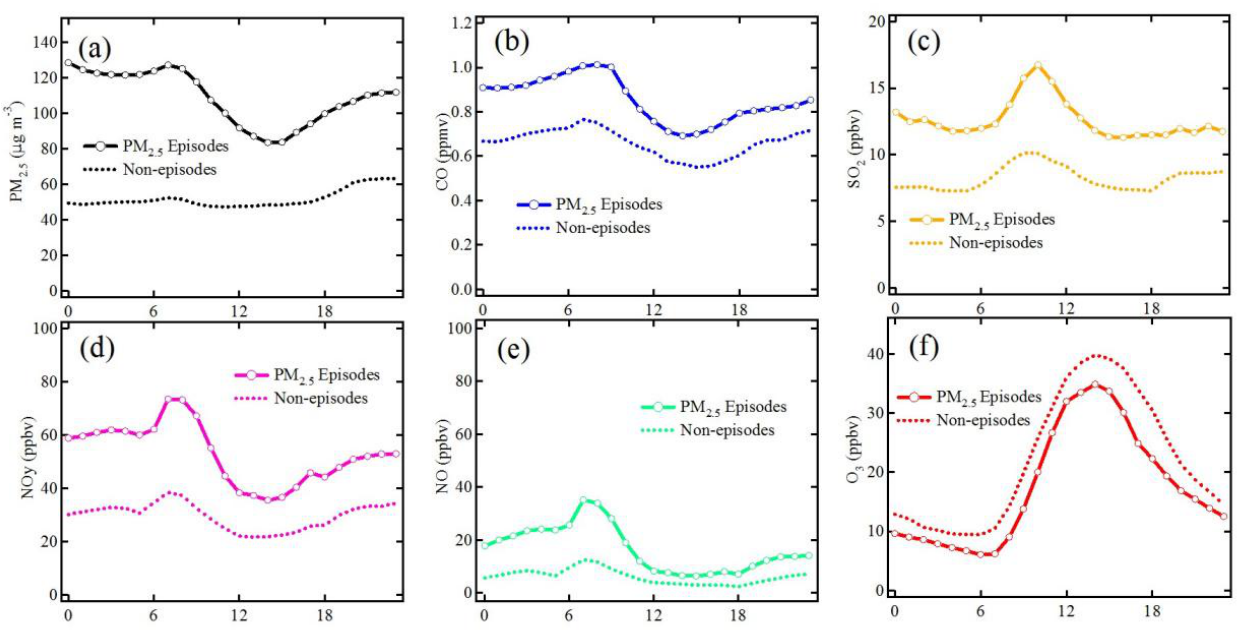
Fig. 6. Diurnal variations of (a) PM 2 . 5 , (b) CO, (c) SO 2 , (d) NO y , (e) NO, and (f) O 3 , averaged for PM 2 . 5 episode days with exceedances of the NAAQS-CN and the non-episode Figure 6. Diurnal variations of ( a ) PM averaged for PM days. 4